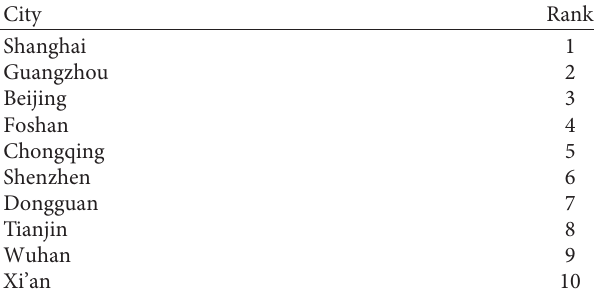
Table 13: Top 10 cities, ranked according to degrees of centrality. Table 15: Regression result for core-periphery effects of asym- metric market